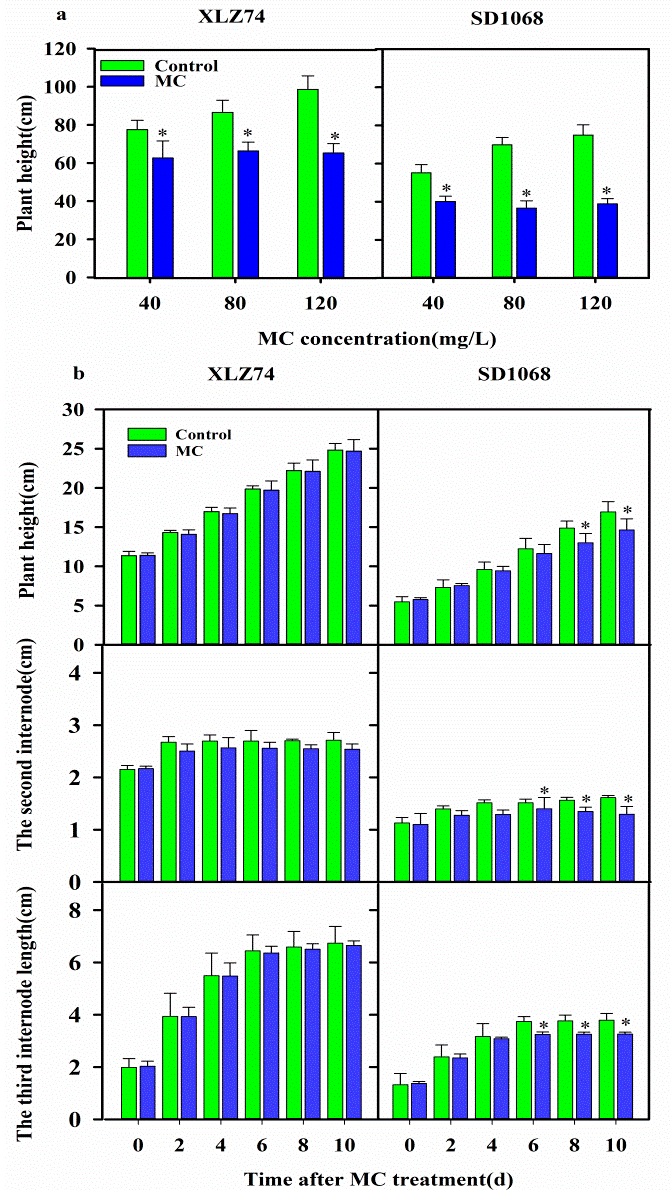
Figure 1. Effects of Mepiquat chloride (MC) treatment on plant height and internode elongation. ( a ) Plant height of cotton seedlings in response to different concentration of MC (40, 80 and 120 mg/L). Each MC concentration was applied to the seedlings three times in a period of 17 days. The plant height was measured 27 days after the 3rd spray. ( b ) Dynamic changes in the plant height and the length of the second and third internodes at 2, 4, 6, 8 and 10 d after spray of 80 mg/L MC. Cotton seedlings with the third true leaf fully expanded were used in the experiments. Error bars represent the SD of three biological replicates, * p < 0.05, Student’s t